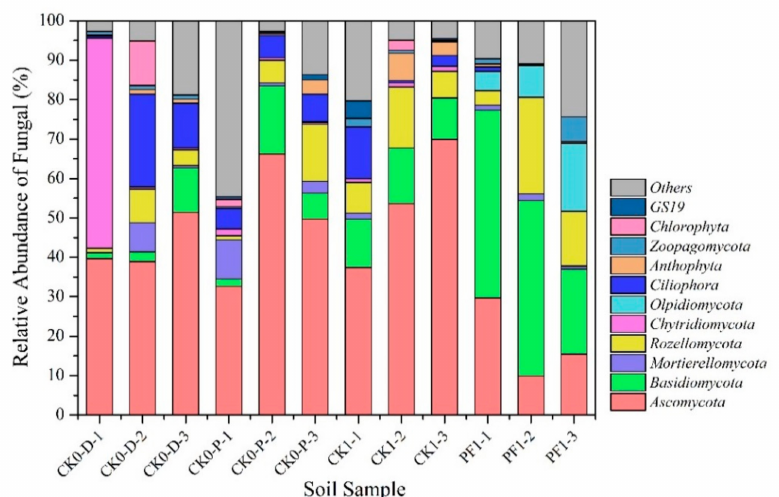
Figure 4. Changes in the relative abundance of fungal phyla in the dryland-to-paddy conversion